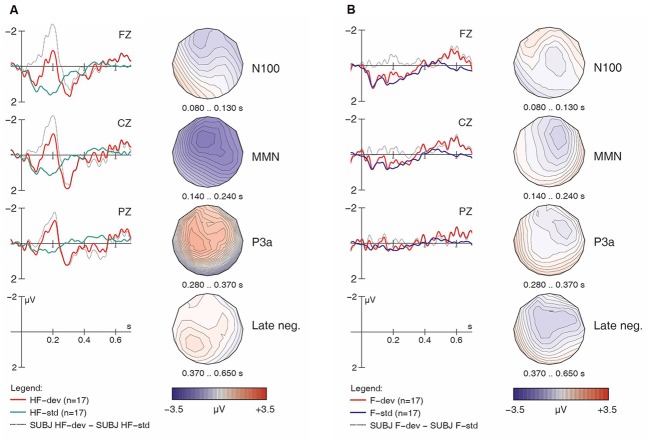
Learner responses to [hf] (A) and [f] (B) items, both standards and deviants, with difference wave and voltage maps. Negativity is plotted upward; vertical axis at 0 ms indicates stimulus onset.